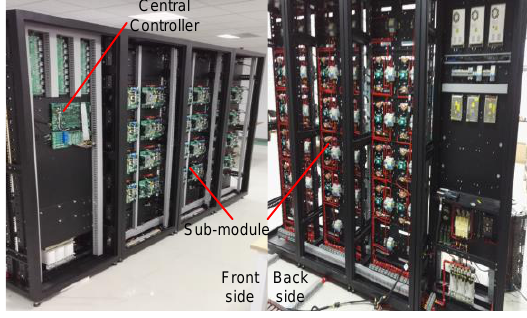
Figure 11. Picture of the prototype.